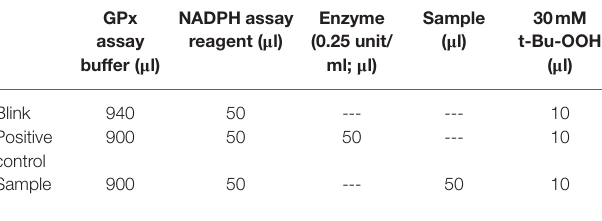
TABLE 2 | Glutathione peroxidase reaction